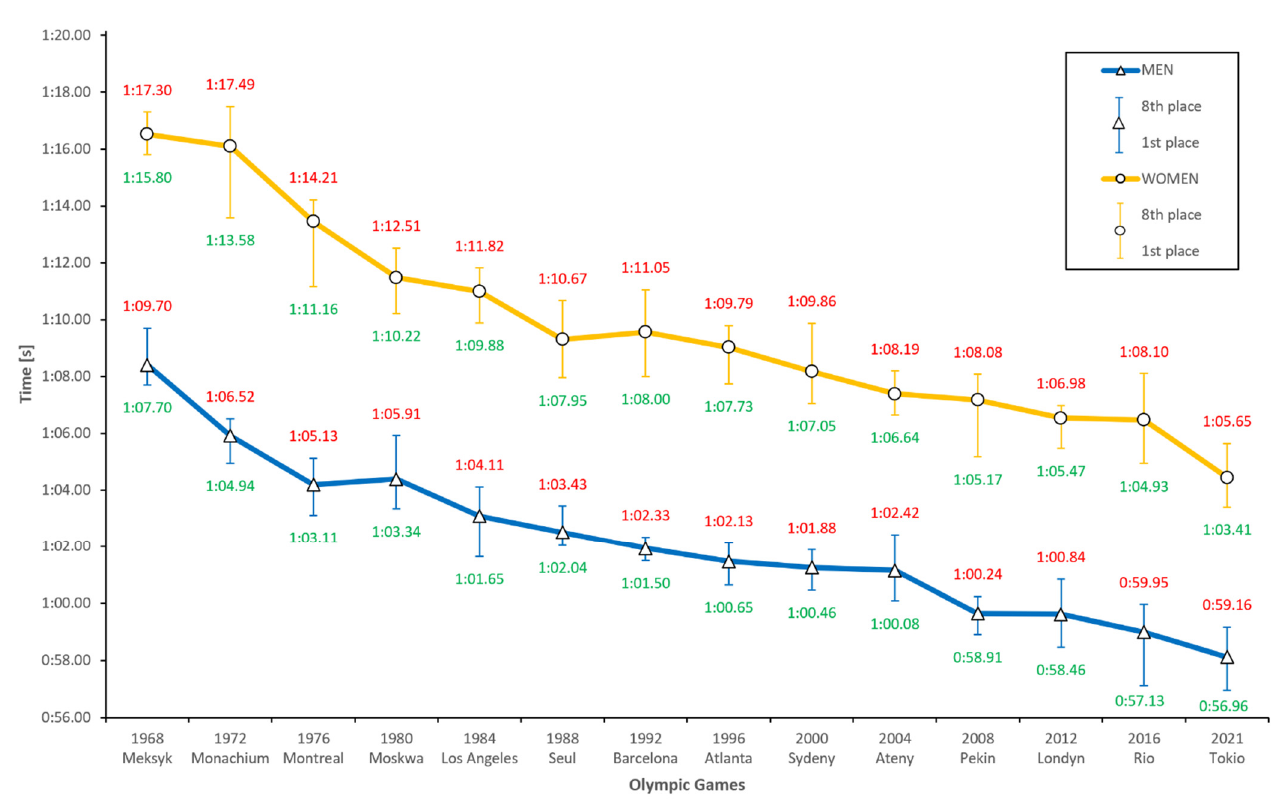
Figure 1. Men’s and Women’s 100 m breaststroke results during the last 13 Olympic Games and prediction for Tokyo 2021. Table 1. Summary of univariate linear regression for the results of the first and eighth place in the finals and the average time of the women’s and men’s finalists in the 100-m and 200-m breaststroke and butterfly stroke along with a prediction of times for the Tokyo Olympic Games in 2021.